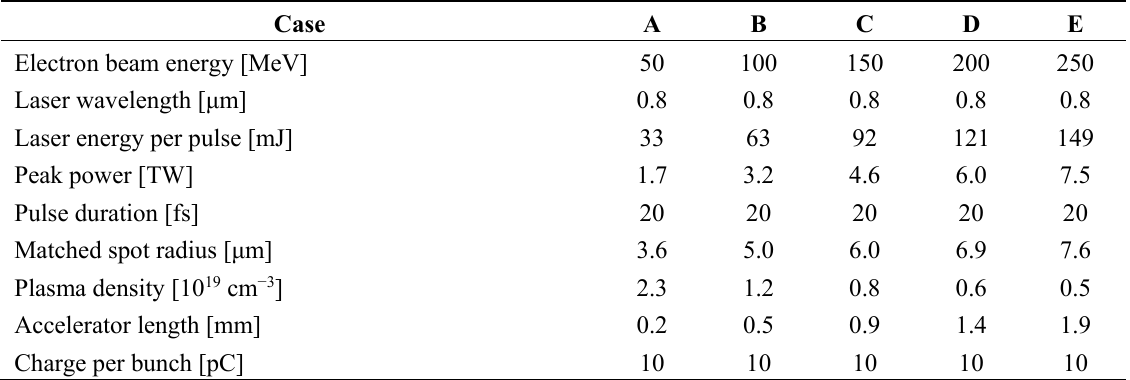
Table 2. Main parameters of laser plasma accelerators for VHE electron beam radiation therapy